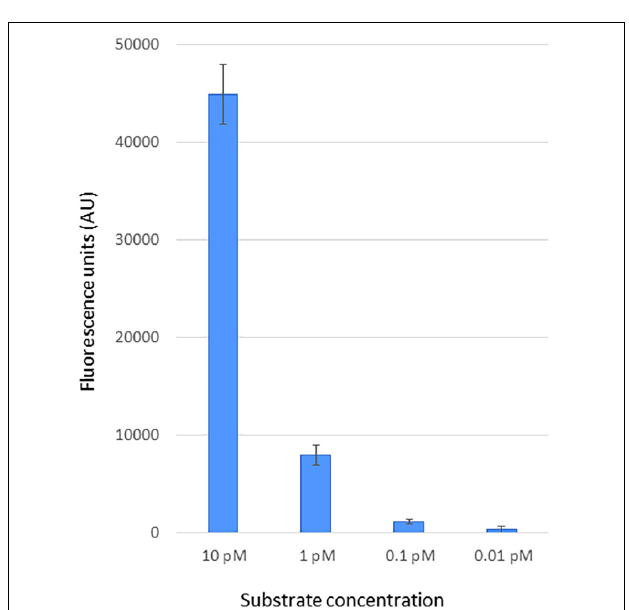
FIGURE 3 | Sensitivity of CRISPR-Cas12a-based BNYVV detection using synthetic DNA targets. The BNYVV RNA1 template DNA encompassing the CRISPR RNA target used in this assay was obtained via PCR using a synthetic DNA. To determine the detection limit, the target DNA fragment was serially diluted 10-fold and subjected to CRISPR-Cas12a reporter assay as mentioned in the Materials and methods section. The output signal of the assay reactions was quantified using a plate reader. In this assay, reactions with no template served as the negative control and were used for background subtraction. The y -axis represents background-subtracted values of fluorescence units, and x -axis shows dilutions of target DNA indicated in picomolar (pM). Error bars, standard deviation (STDEV) on replicates ( n = 3).